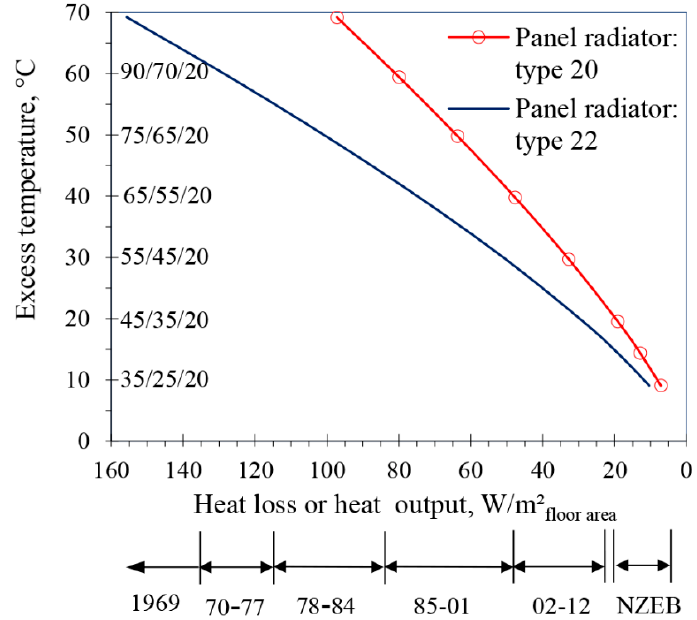
Figure 3. The evolution of energy efficiency in German buildings between 1969 and 2012 [42]. The values on the right hand side of ordinate (y-axis) show supply/return/room temperatures. Radiator dimensions: length = 1.2 m, height = 0.5 m. NZEB = Near - Zero Energy Building.